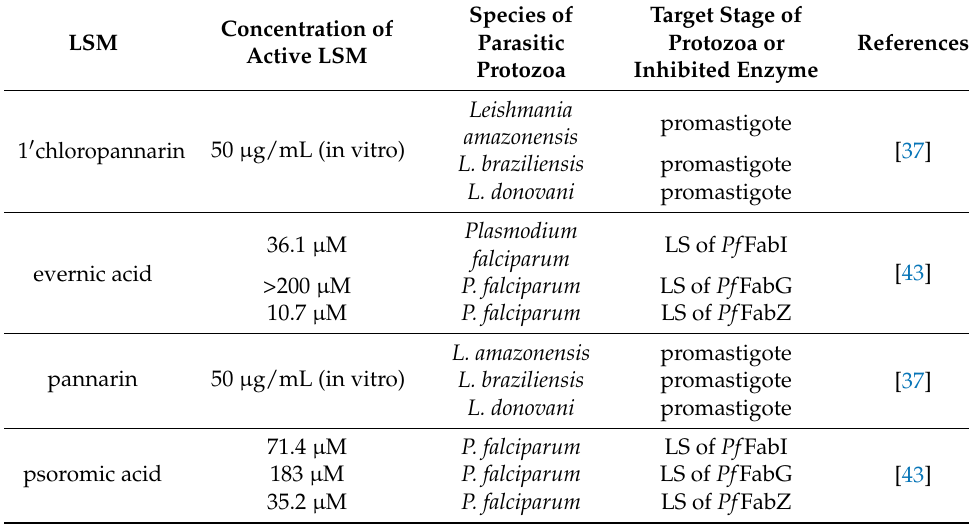
Table 2. LSMs that have antiprotozoal activity on parasitic diseases transmitted by insect vectors, the target stage of the parasite and the effective concentrations (LS = liver stage; Pf FabI, Pf FabG, Pf FabZ = enzymes of type II fatty acid biosynthesis (FAS-II) pathway in Plasmodium falciparum